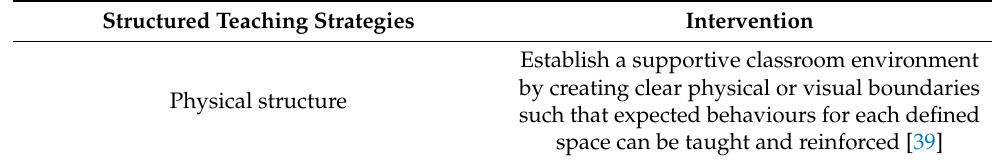
Table 3. Individualised instructional practices in schools for children with